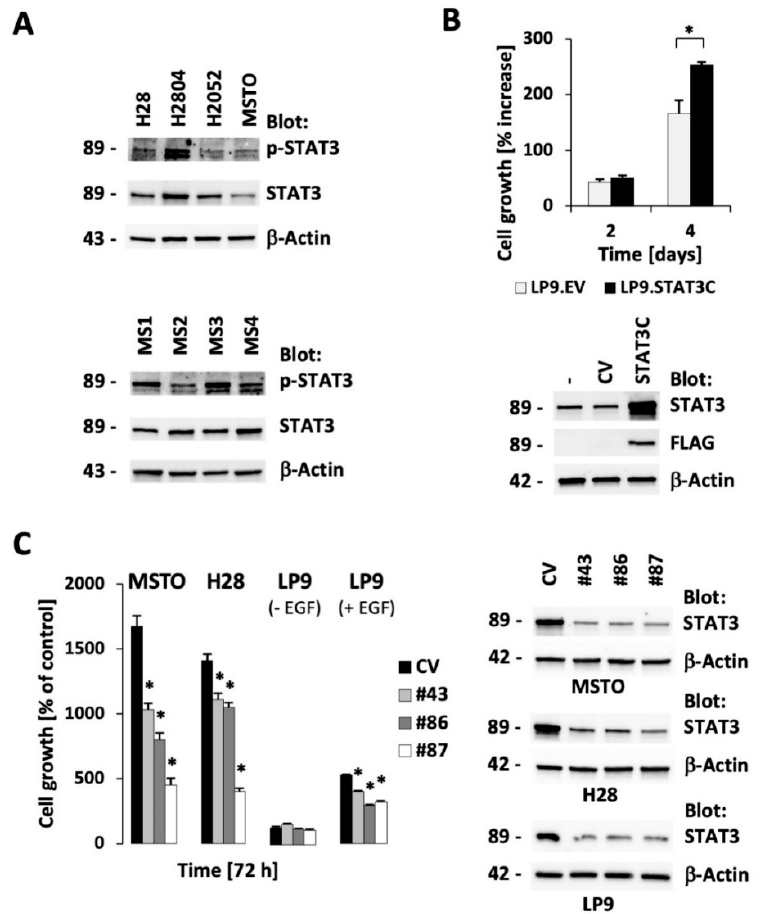
Figure 1. Signal transducer and activator of transcription 3 (STAT3) is phosphorylated in Malignant pleural mesothelioma (MPM) cells and its expression is required for optimal cell growth. ( A ) Protein expression of STAT3, phospho-STAT3 (Tyr705), and β -actin was measured by immunoblotting in established cell lines (H28, H2804, H2052, MSTO-211H (MSTO); top) and MPM primary-derived cell lines (MS1-MS4; bottom). ( B ) LP cells expressing active STAT3 (STAT3C) or contain- ing a control vector (EV) were generated and growth was measured in a four-day culture (* significant differences with p < 0.05; top). Protein expression of STAT3, FLAG-tagged STAT3 and β -actin was determined by immunoblotting (bottom). ( C ) RNA silencing of STAT3 was performed in cell lines (MSTO-211H (MSTO), H28, LP9) and growth ( n = 4) was measured using different small hairpin RNA (shRNA) expression constructs, as indicated (* significant differences with p < 0.005, left). Protein expression was measured by immunoblotting in response to STAT3 knockdown, as indicated (right). The molecular weights (in kDa) for each detected protein are indicted on the left of each immunoblot.